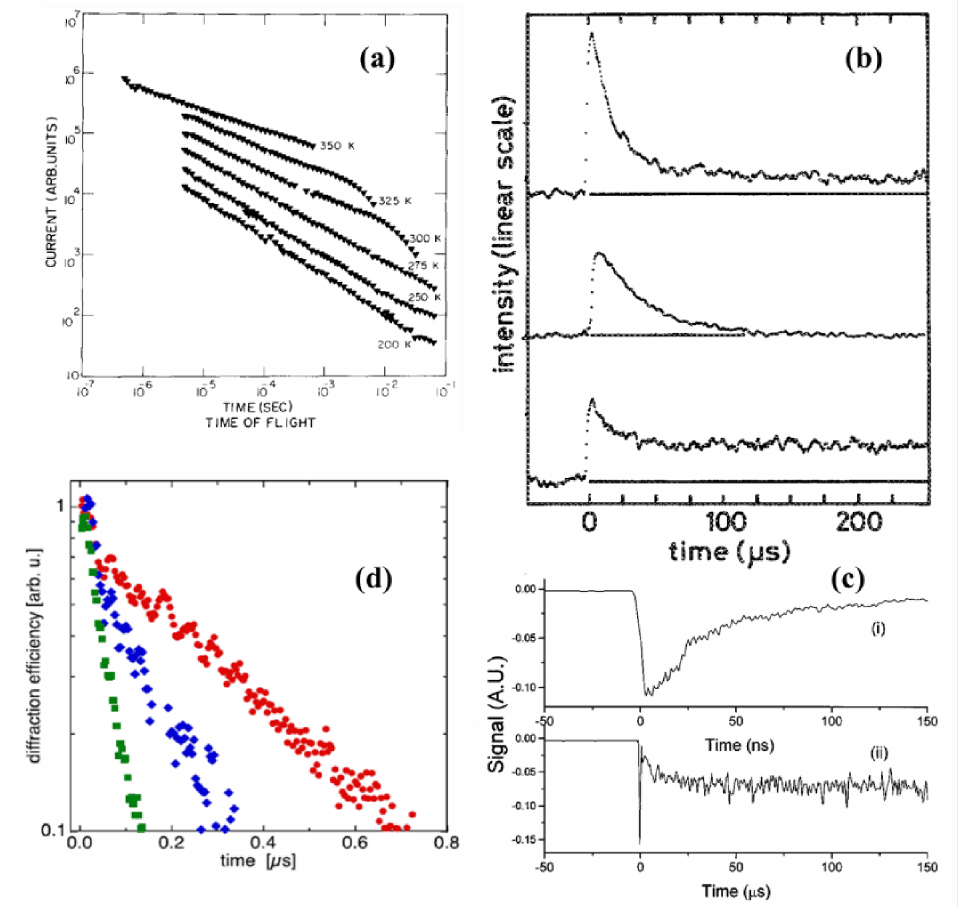
Figure 8. ( a ) Temperature dependence of time-of-flight (TOF) current transients. All Figures are reprinted with permission from [51] Copyright 1983, Elsevier. ( b ) Time evolution of diffracted light intensities from grated As 2 S 3 films in the annealed state (top), under bias illumination at room temperature (middle), and in annealed state at 80 K (bottom). All Figures are reprinted with permission from [53] Copyright 1989, American Institute of Physics. ( c ) The diffracted signal consists of a nanosecond transient (i) component that is followed by a slow asymptotic after-pulse effect (ii). The transient effects are instantaneous with the laser pulse. All Figures are reprinted with permission from [54] Copyright 1999, American Institute of Physics. ( d ) Temporal evolution of the diffraction efficiency of a photoinduced transient grating in the a-As 2 Se 3 film for three spatial periods of 0.7, 1.1, and 1.6 µ m. All Figures are reprinted with permission from [55] Copyright 2012, American Institute of